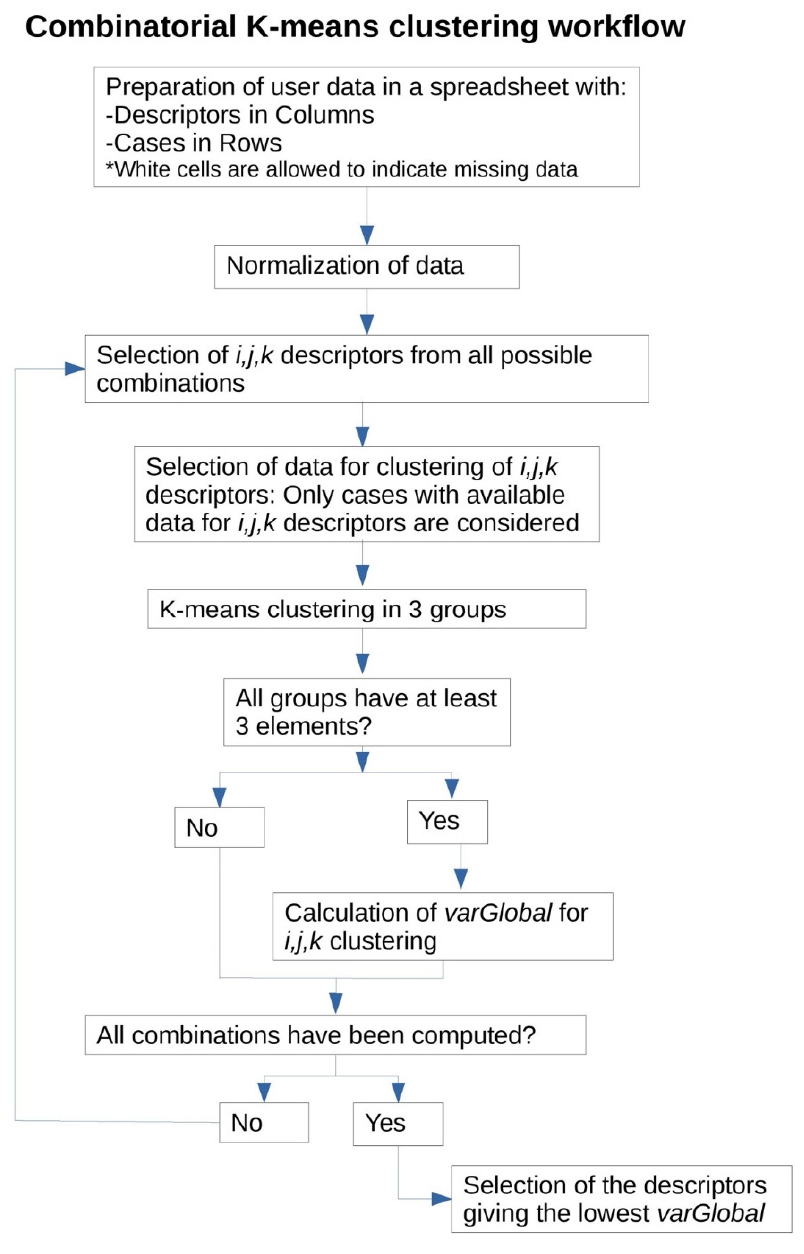
Figure 1. Workflow Figure 1. Workflow diagram.